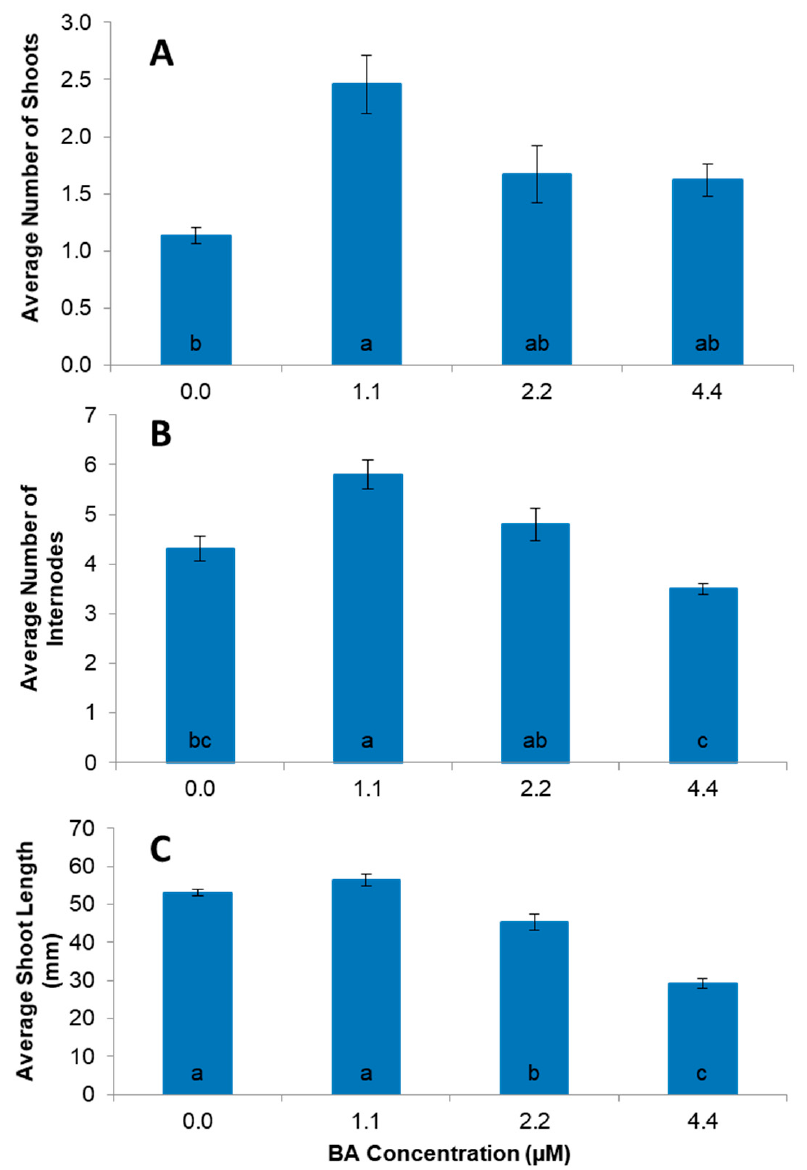
Figure 3. The effect of various concentrations of BA added to Murashige and Skoog basal (MS) medium on average number of shoots ( A ), number of internodes ( B ) and shoot length ( C ) of ‘ Vrinda ’ nodal explants after 4 weeks of culture. Data represent mean ± standard error from about 36 explants per treatment and three replications. Means from all the treatments were compared with each other using Tukey’s test. Vertical bar with same letters indicates no significant difference between treatments at ( p > 0.05).